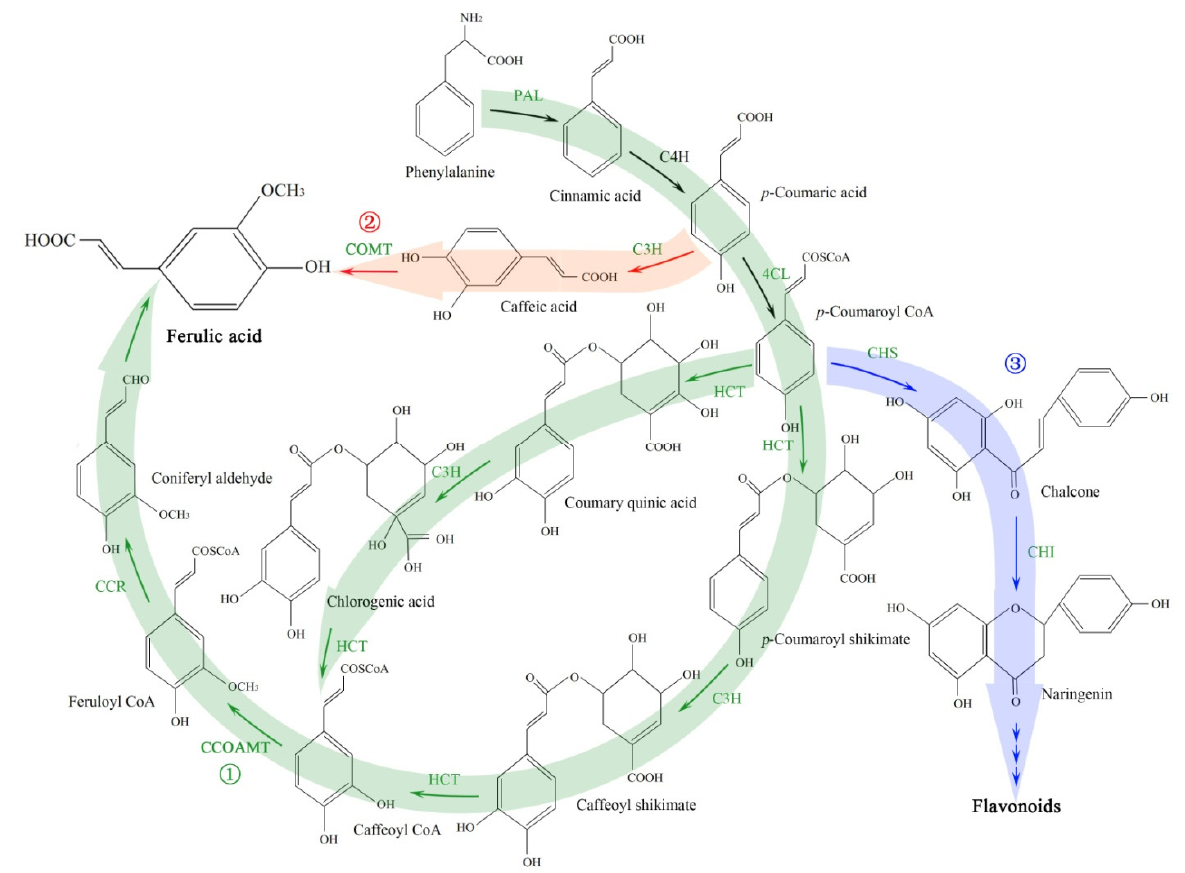
Figure 1. Schematic representation of biosynthetic pathways leading from shikimic acid pathway to phenylpropanoid pathway. Solid arrow indicates known steps, whereas multiple arrows indicate multiple reaction steps. Enzyme abbreviations are as follows: EMB3004, Bifunctional 3-dehydroquinate dehydratase/shikimate dehydrogenase, chloroplastic; CM, chorismate mutase; PAL, phenylalanine ammonia lyase; C4H, cinnamate 4-hydroxylase; 4CL, 4-coumarate-CoA ligase; HCT, hydroxycinnamoyl shikimate transferase; C3H, p -coumarate 3-hydroxylase; CCOAMT, caffeoyl-CoA 3-O-methyltransferase; CCR, cinnamoyl CoA oxidoreductases; COMT, caffeic acid 3-O-methyltransferase; CHS, chalcone synthase; CHI, chalcone isomerase. ① Showing the ferulic acid biosynthesis via CCOAMT sub-pathway; ② Showing the ferulic acid biosynthesis via COMT sub-pathway; ③ Showing the flavonoid biosynthetic sub-pathway.